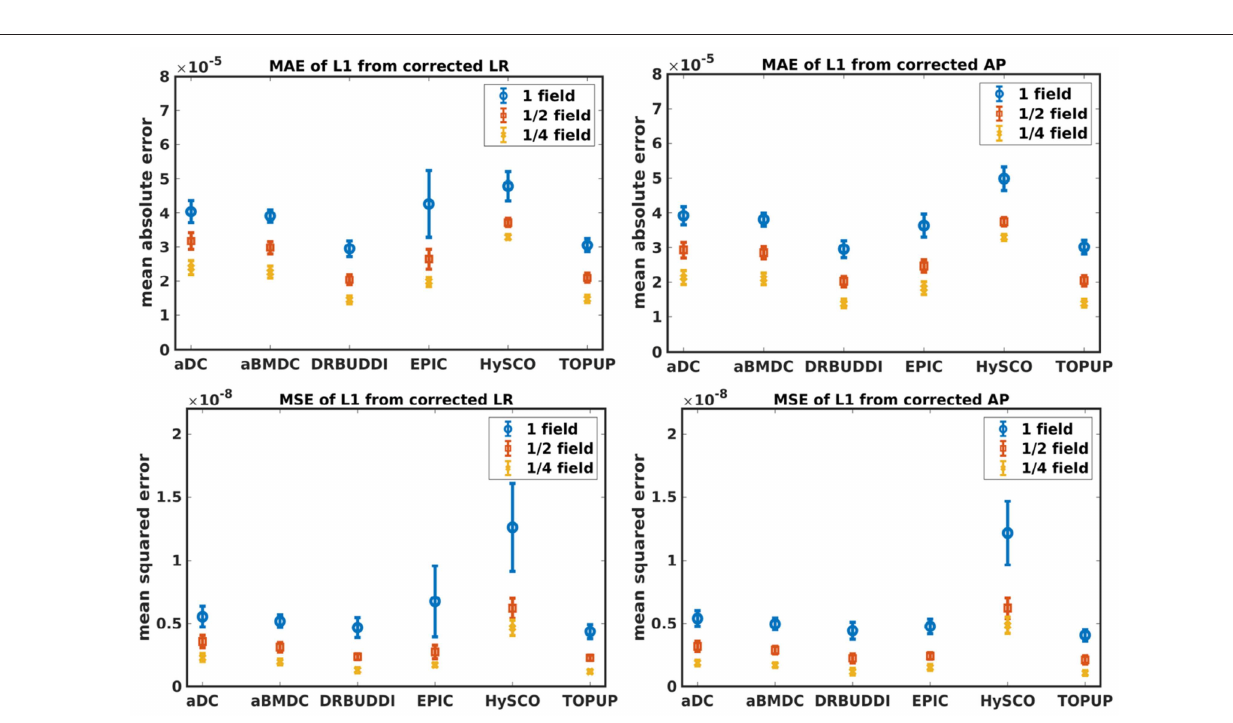
Frontiers in Neuroinformatics |